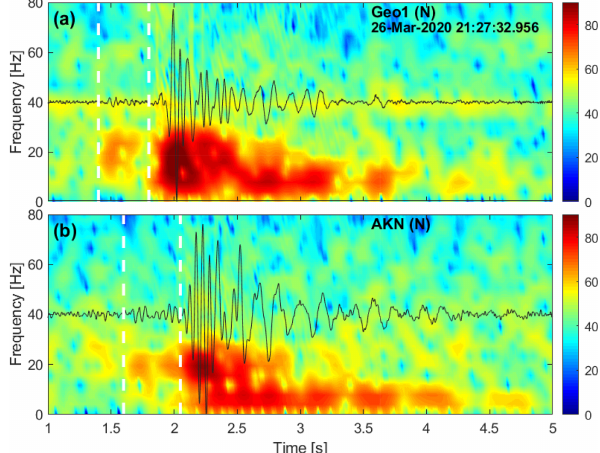
Figure 12. Example of a complex slope quake with precursory sig- nal as defined by Provost et al. (2018). The level of detail necessary for its classification requires higher-resolution computation param- eters and is difficult to capture by the CNN. Signal recorded on the north component of (a) a surface geophone; (b) the broadband seis- mometer (AKN). The white vertical dashed lines mark two phases, the second being the most